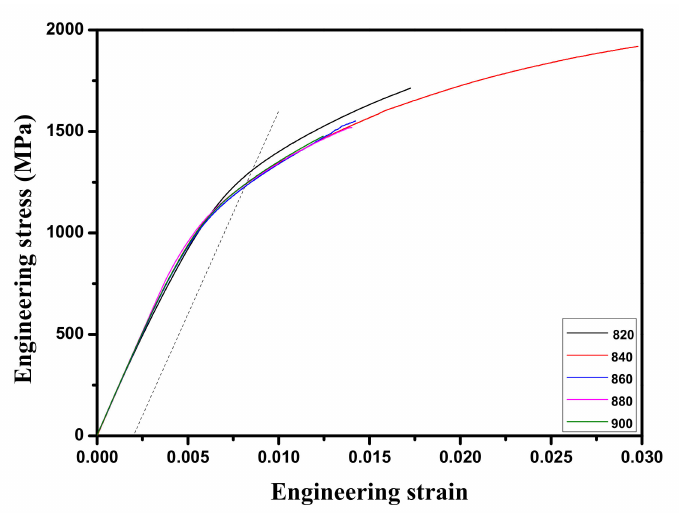
Figure 6. Tensile stress–strain curves of the specimens austenitized at different temperatures as indicated by the serial number.